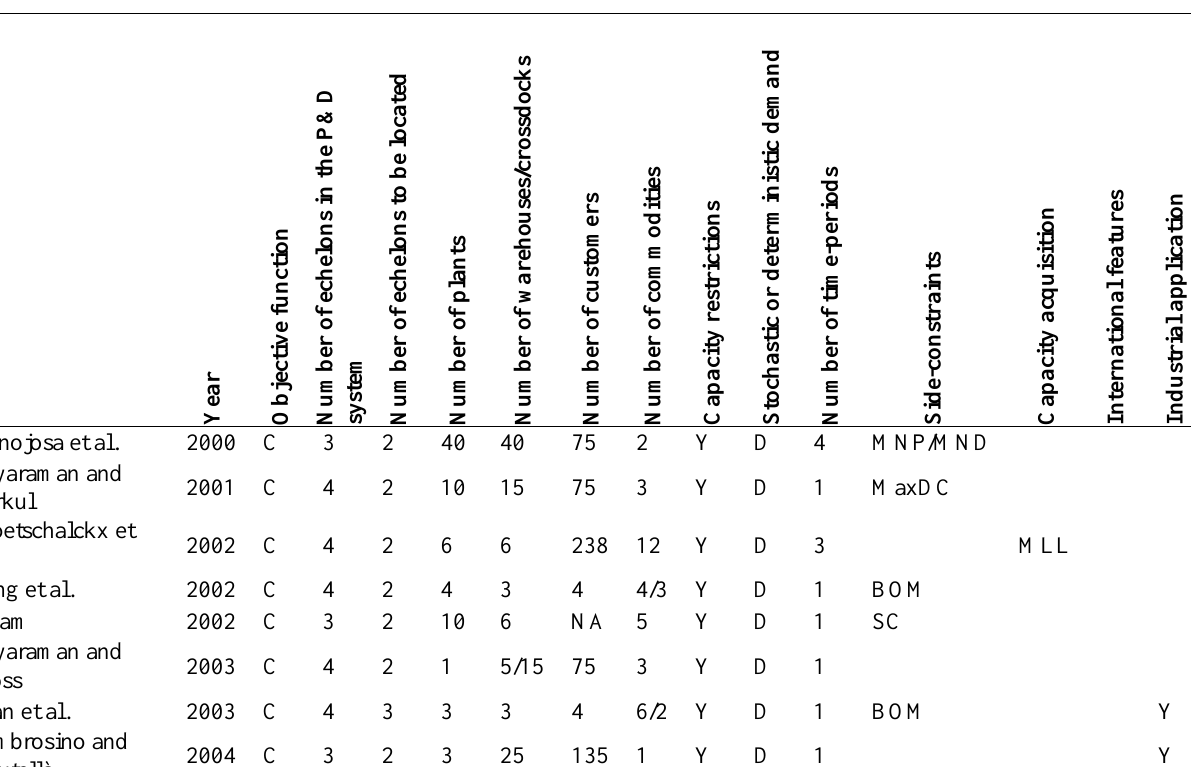
Table 3. Multiple echelon location